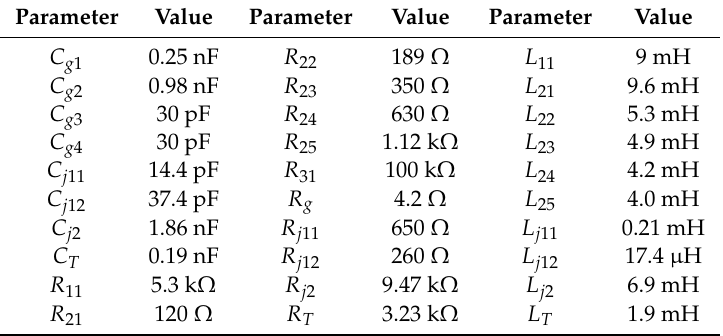
Table 1. Values of electric parameters of the